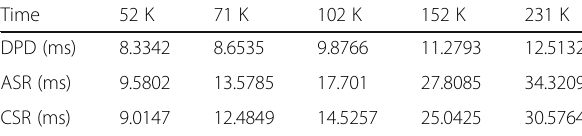
Table 3 Performance comparison of the three methods Time